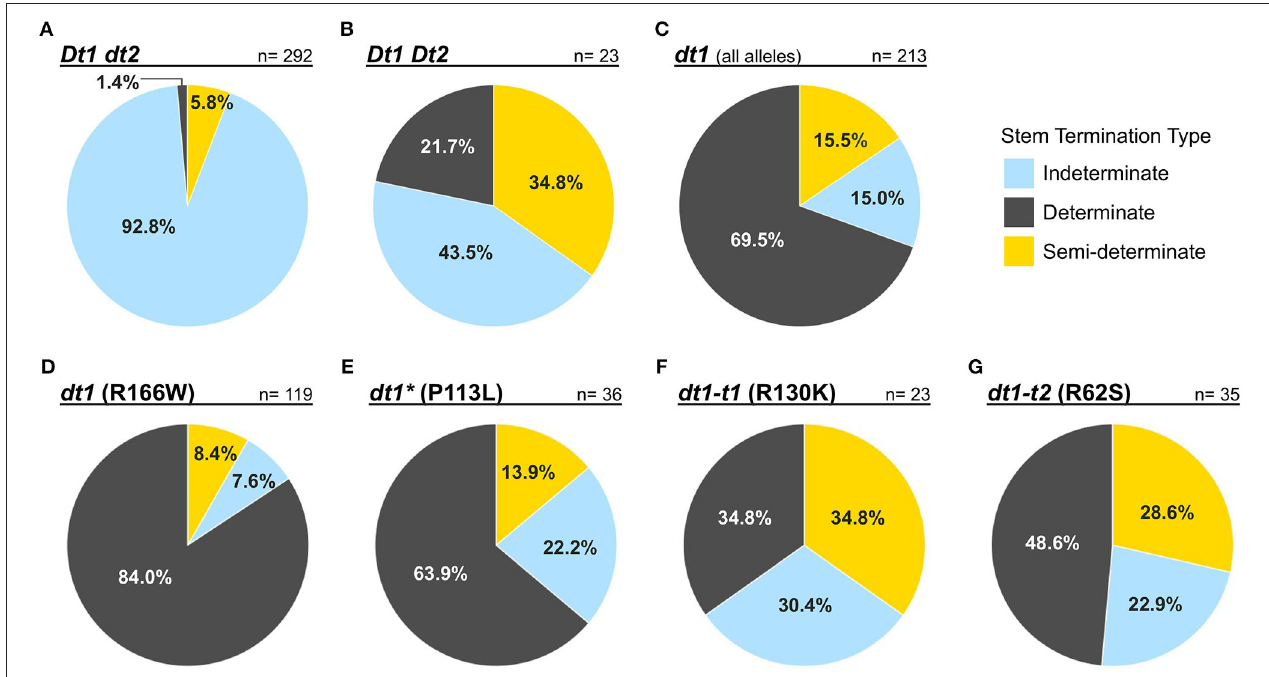
FIGURE 1 | Pie charts showing the rates of concordance between publicly available phenotypes and genotypes for stem termination types of 528 G. max accessions. The phenotype data were downloaded from the GRIN database. Each of the evaluated phenotypes was highlighted by colors—blue: indeterminate; yellow: semi-determinate; gray: determinate. Genotype categories about which each of the pie charts illustrates were written in bold and italic characters above of lines drawn over each chart. Percentages written in pie charts represent rates on how often people evaluated the stem termination types of soybean accessions within each genotype category. Digits followed by n = represented numbers of the G. max accessions within each genotype category. (A–C) Illustrate how stem termination types of soybean accessions with each genotype combination for the Dt1 and Dt2 genes that have been phenotypically scored. (D–G) Showed variations in scored phenotypes depending on the presence of each of the four missense mutations at the dt1 locus: dt1 (R166W) represents the standard determinate stem type, dt1-t1 (R130K), and dt1-t2 (R62S) represent the tall determinate stem type alleles, and dt1 * (P113L) represents another frequently found missense mutation at the dt1 locus, which is only mentioned in the analysis on